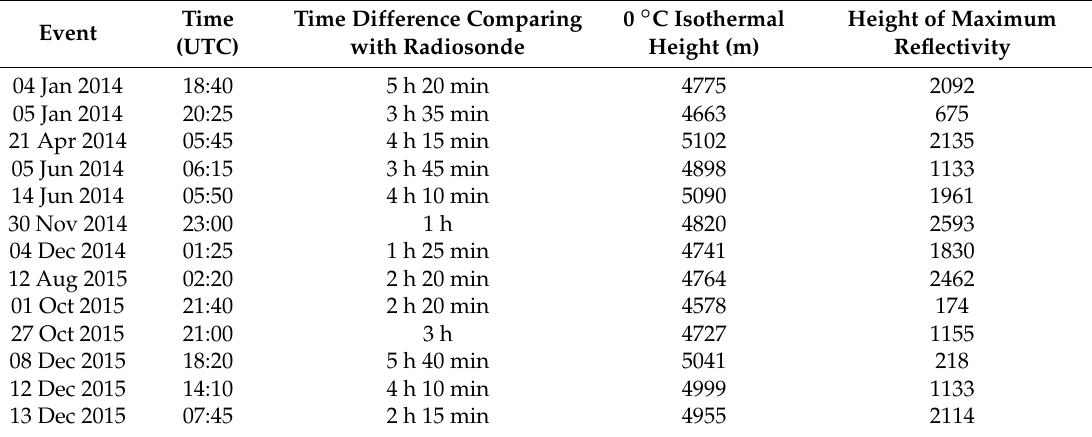
Table 1. Convective rain melting layer events with closest radiosonde